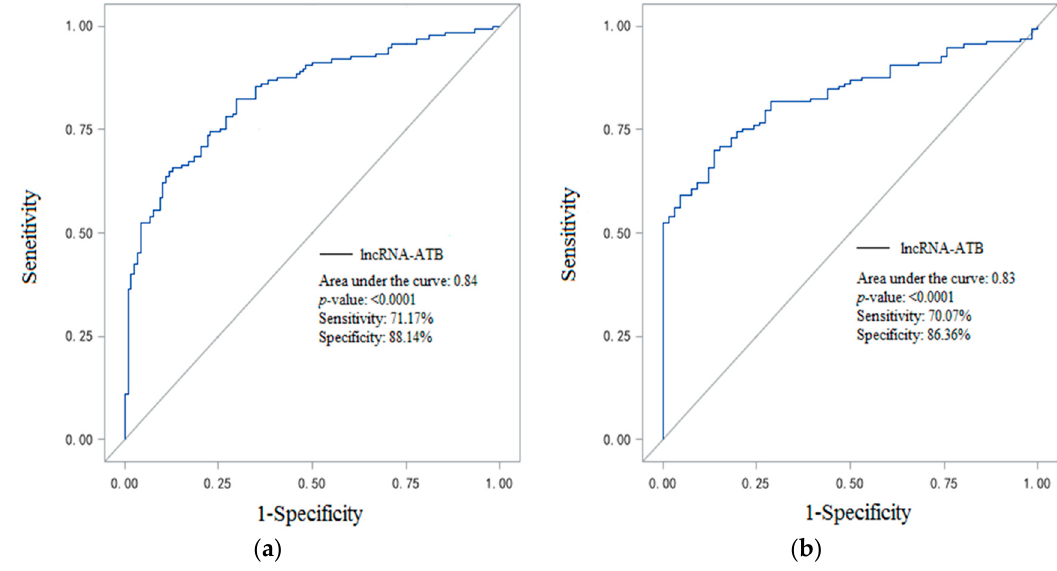
Figure 2. Receiver operating characteristic (ROC) curve analysis for lncRNA ‐ ATB in plasma adjusted for risk factors; ( a ) Compared with healthy controls; and ( b ) compared with healthy coal miners.